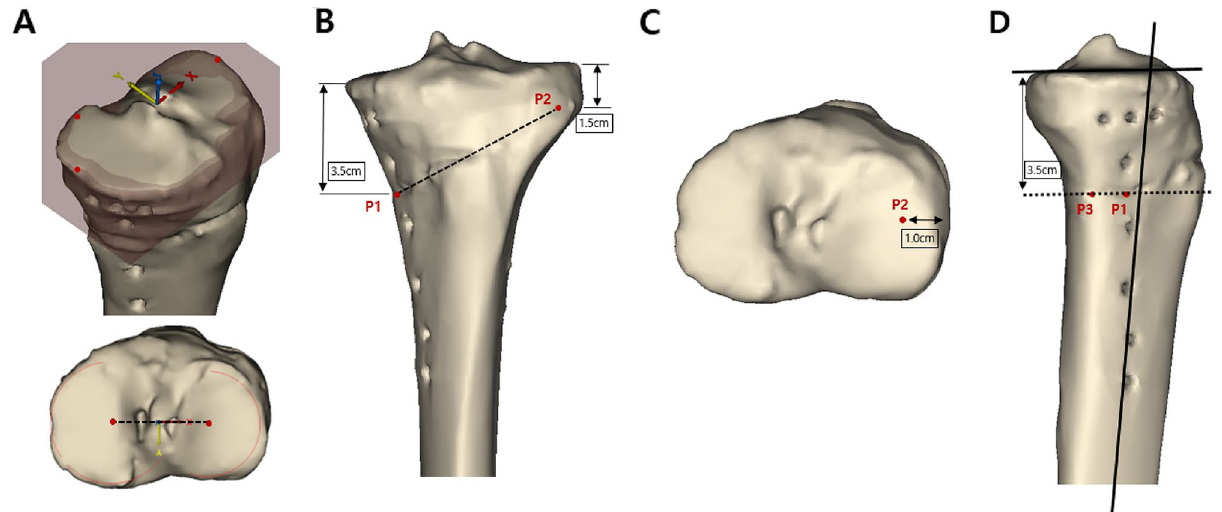
Figure 2. Positioning of point 1 (P1), point 2 (P2), and point 3 (P3) on the three-dimensional (3D) images of tibia. A. Determination of the joint plane and the coordinate system of proximal tibia by defining the x -, y -, and z -axes in the 3D model. The joint plane was defined by the 3 points (the most medial point of the medial tibial plateau, the most posterior point of the medial tibial plateau, and the most lateral point on the lateral tibial plateau). The x- axis was defined by the line connecting the centers of the best-fit circles of the medial and lateral plateau on the joint plane. The y- and z- axes were defined by cross-product of the x-axis B. Initially, P1, the starting point of osteotomy, was placed on the anteromedial cortex of proximal tibia, 3.5 cm below the medial end of the tibial plateau. P2, which was used as a hinge, was located 1.0 cm medially from the lateral cortex of tibia on the x-axis and 1.5 cm below the articular surface on the z-axis. C. In the axial plane, P2 was positioned at the midpoint of the entire length of anteroposterior articular surface. D. In the sagittal plane, P3 was placed at the posteromedial cortex of tibia. The angle between the line formed by P1 and P3 and the line of the medial tibial plateau was defined as the osteotomy inclination angle in the sagittal plane. These figures were created using the Mimics software (version 17; Materialise, Leuven, Belgium).